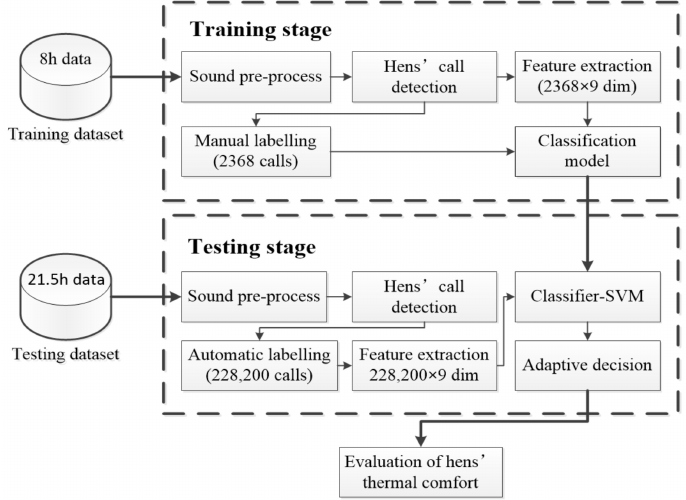
Figure 3. Flow chart of automatic hens’ call